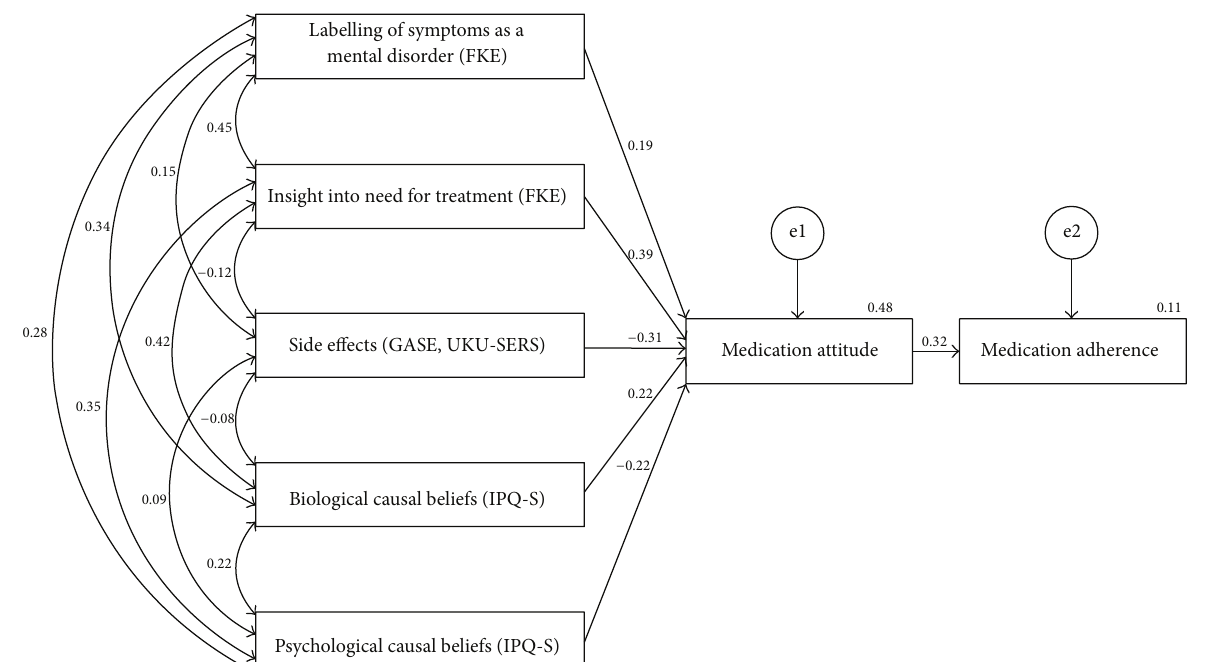
Figure 2: Path analysis to explain the variance in medication adherence with medication attitudes and related variables.